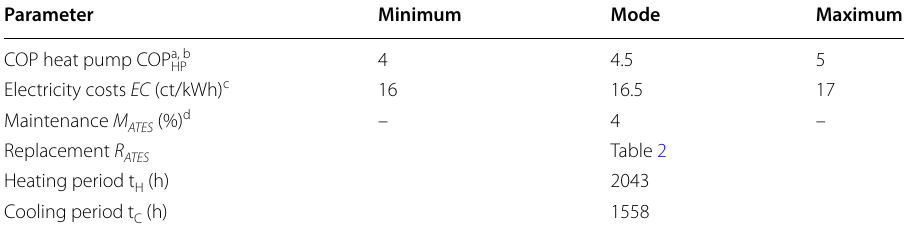
Table 5 Input parameters to calculate the current costs of the ATES system